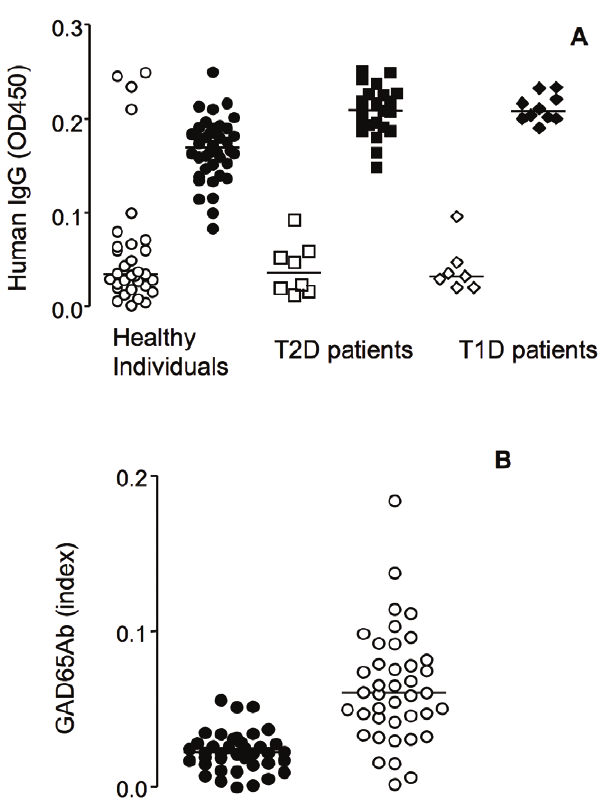
Figure 3. MAb 8E6G4 binds GAD65Ab present in human sera. A: Human sera obtained from GAD65Ab-negative healthy individuals (circles) (n=40), GAD65Ab-negative T2D patients (squares) (n=22), and T1D patients (diamonds) (n=10), were analyzed for binding to MAb 8E6G4 by ELISA. Binding of human sera to three mouse monoclonal antibodies specific to human HGF is shown as a negative control (open symbols). Median binding is indicated. B: Human sera obtained from healthy individuals (n=40) (GAD65Ab-negative in RBA) were tested for presence of masked GAD65Ab. Sera were precipitated on immobilized MAb 8E6G4, and subsequently eluted. Elutions were tested for presence of GAD65Ab by RBA. GAD65Ab titers of sera prior to precipitation (black circles) and elutions (open circles) are presented as GAD65Ab index. Median binding is indicated.